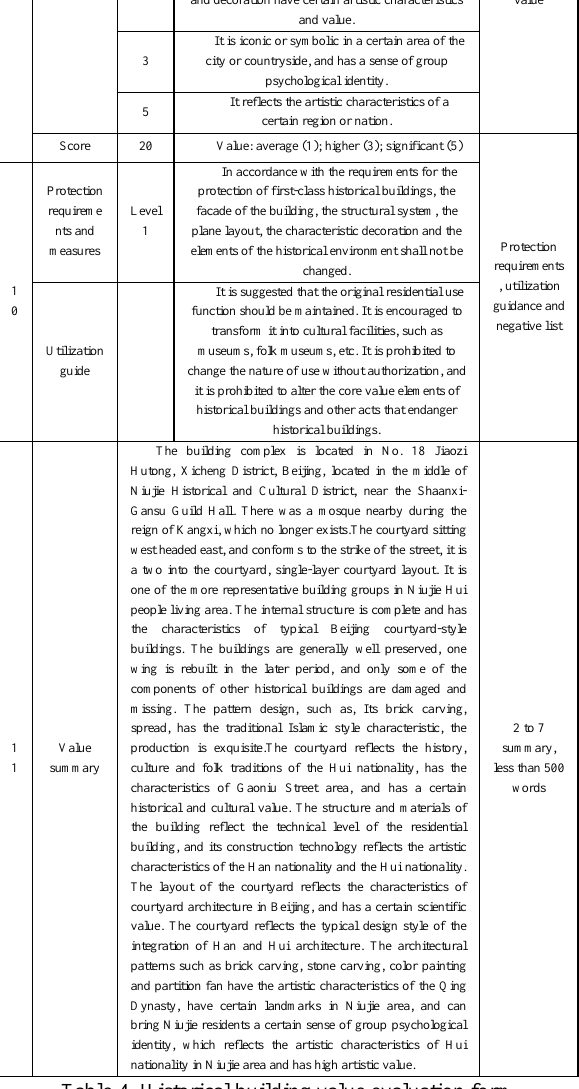
Table 4. Historical building value evaluation form Each historical building in Niujie Street is evaluated and scored by using the above methods, and the grade of historical building is evaluated according to the score.